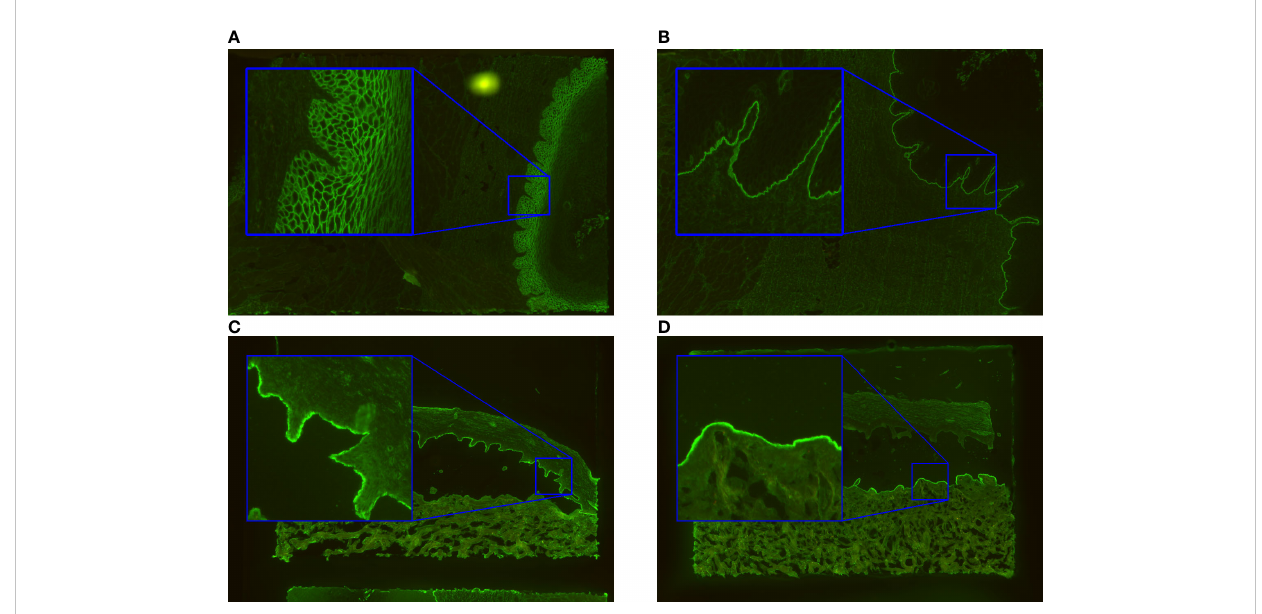
FIGURE 1 Exemplary immuno fl uorescence images of the incubated substrates esophagus and salt-split skin. The ‘ intercellular ’ pattern seen by intercellular labelling of monkey esophagus in pemphigus vulgaris/foliaceus is shown in (A) . In (B) , the basal membrane zone ( ‘ BMZ ’ ) pattern typical for pemphigoid diseases is indicated. The patterns found in salt-split skin are ‘ epidermal ’ (C) and ‘ dermal ’ (D) . They arise by binding of autoantibodies in pemphigoid patients to the epidermal or dermal side of the arti fi cial